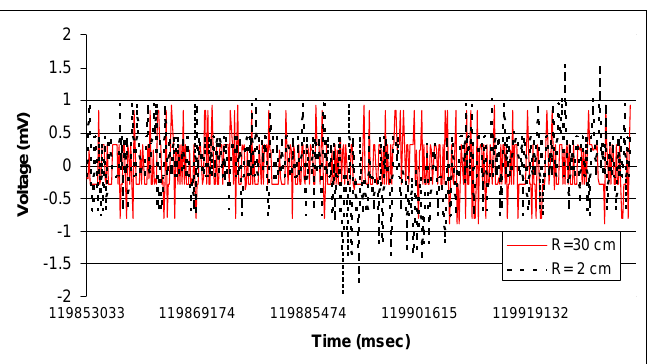
Figure 12. The accelerometer values recorded for R = 30 cm and R = 2 cm.